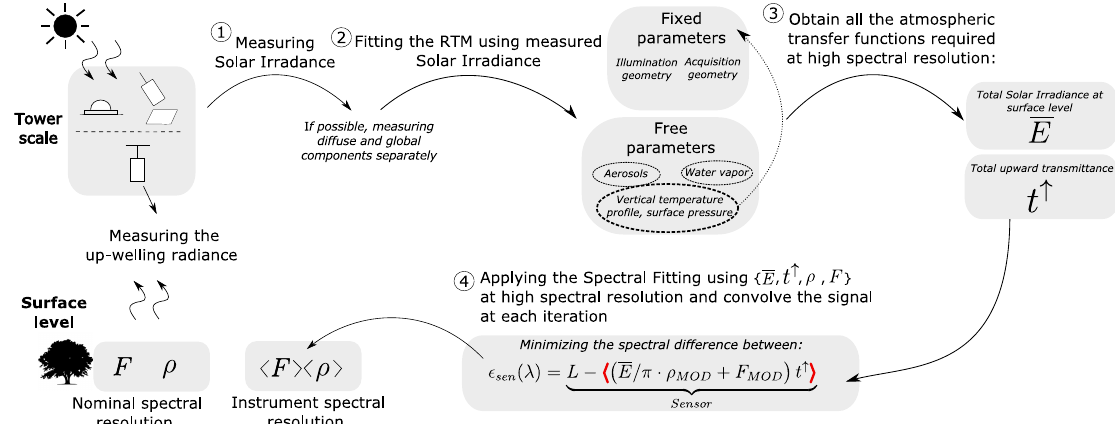
Figure 4. Adaptation of a standard airborne atmospheric correction scheme when applying the SFM SIF retrieval approach for proximal sensing data. Red bold angle brackets in step 4 indicate the signal to be convolved according to the